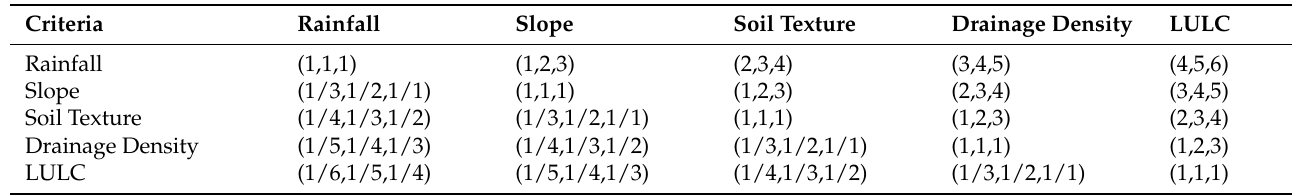
Table 8. Fuzzy AHP comparison matrix.